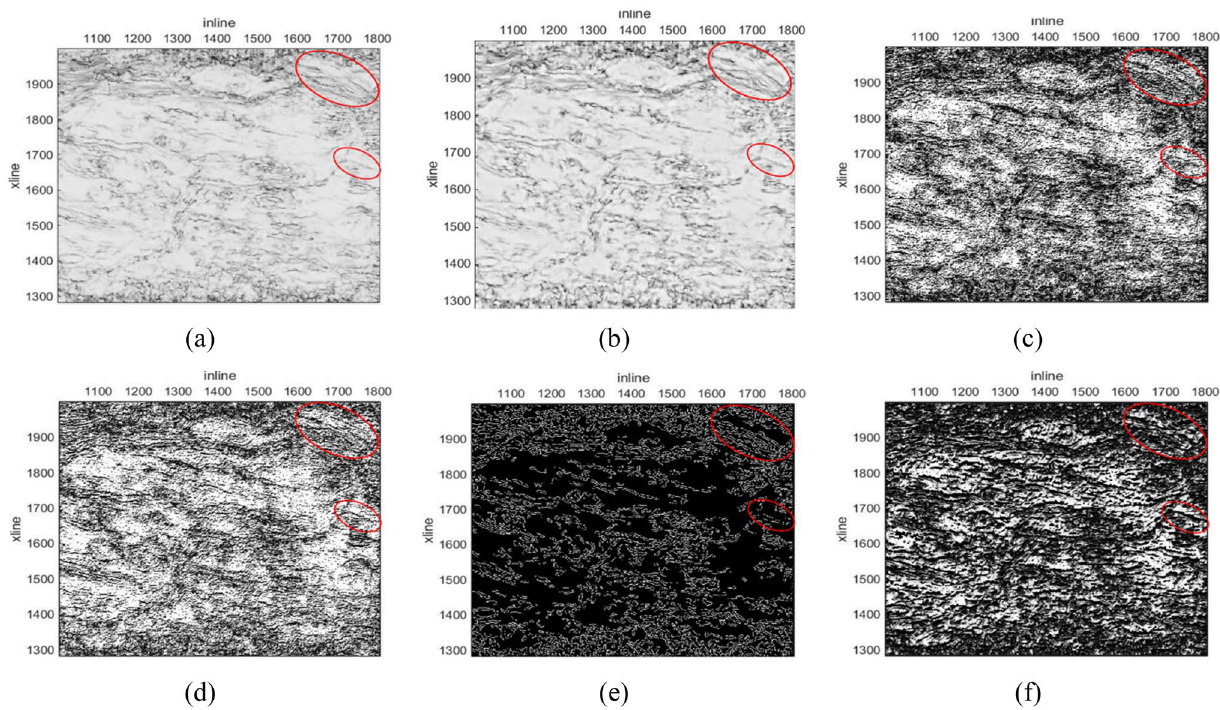
Fig. 6 Results of the study area plane test a Original picture and the results obtained by the b coherence operator; c LBP/VAR method; d median filtering- LBP/VAR method; e guided filtering- Canny method; and f guided filtering- LBP/VAR method